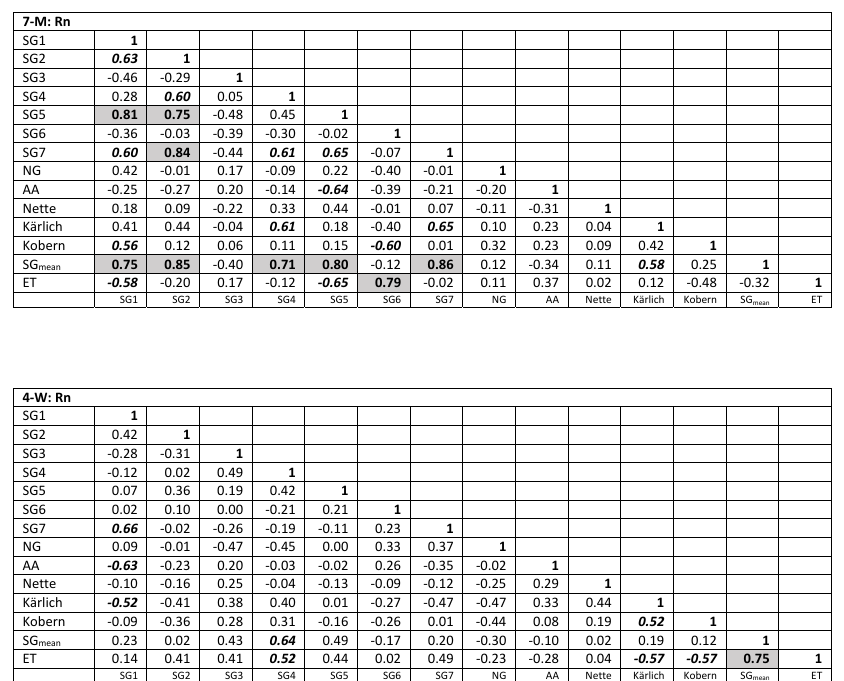
Figure A5. Correlation coefficients between Rn fluctuation patterns in NG, SG, SG mean , mineral springs, and Earth tides (ET) for the 7-M and 4-W samples. Correlations > 0.70 are shaded. Correlations 0.5–0.7 are marked in bold-italic.